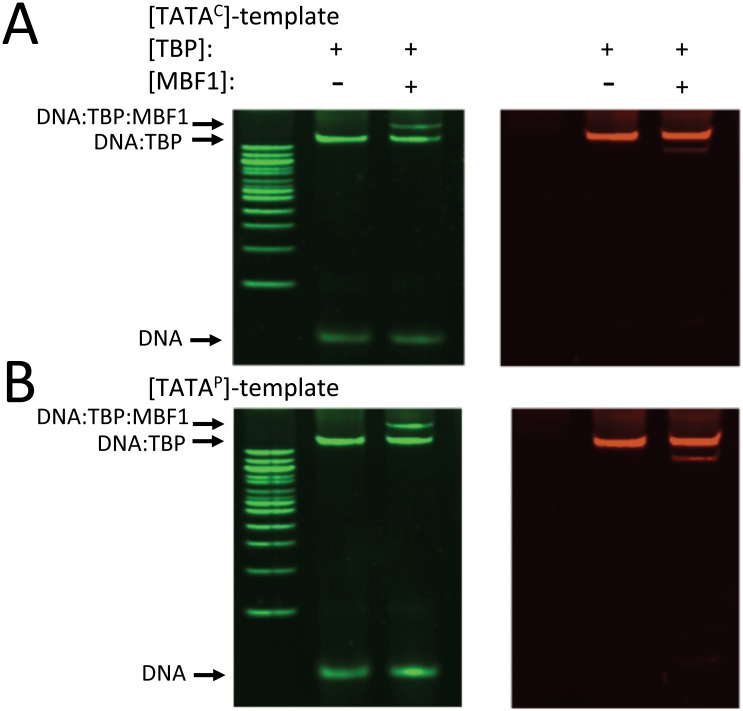
EMSA analysis of BbMBF1-TBP-TATA-oligo complex formation.(A) Interaction of BbTBP and BbMBF1 to TATAC-template. BbTBP (1129 nM) was incubated with TATAC-template (16.8 nM) with and without BbMBF1 (855 nM) and analyzed on 6% non-denaturing PAGE as detailed in the Methods section. Left panel, gel visualized with nucleic acid strain (green), right panel, gel visualized with protein stain (red). (B) Interaction of BbTBP and BbMBF1 to TATAP-template. BbTBP (1129 nM) was incubated with TATAC-template (18.3 nM) with and without BbMBF1 (855 nM) and analyzed on 6% non-denaturing PAGE as detailed in the Methods section. Left panel, gel visualized with nucleic acid strain (green), right panel, gel visualized with protein stain (red).